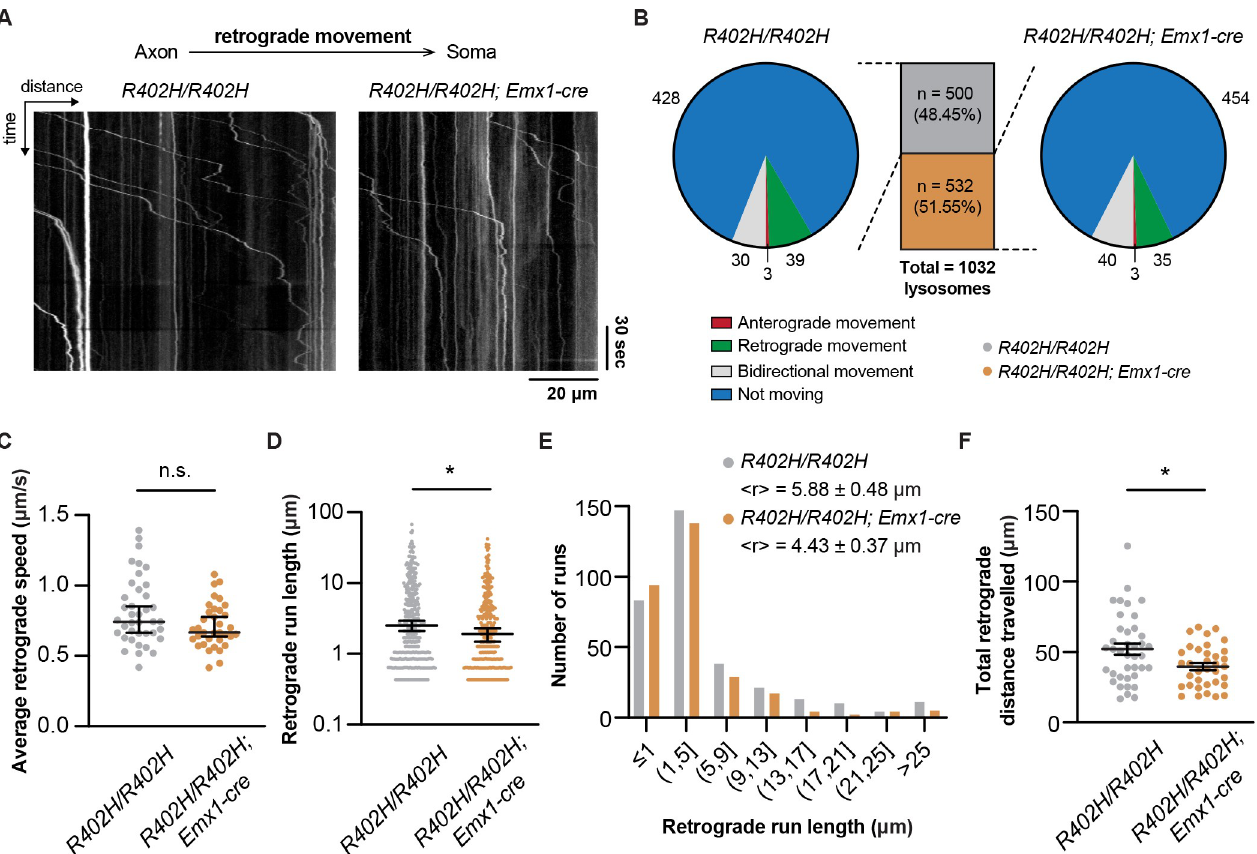
Fig 7. The R402H mutation perturbs dynein-mediated lysosomal transport. (A) Representative kymographs generated from lysosomes tracked in E18.5 primary cortical neurons in R402H/R402H controls and R402H/R402H; Emx1-cre mutants at DIV3. (B) Lysosomes (n = 1032) were classified according to their movement: anterograde, retrograde, bidirectional, immobile. There was no significant difference in the types of movement when comparing genotypes (Chi-square: 3.078, DF = 3, P = 0.3797). (C) We observed no difference in the average retrograde speed when comparing genotypes (n = 39 lysosomes for R402H/R402H controls and n = 35 lysosomes for R402H/R402H; Emx1-cre mutants P > 0.05), but a significant reduction in lysosomal retrograde run length (D) in R402H/R402H; Emx1-cre mutants (n = 343 runs for R402H/R402H controls and n = 309 runs for R402H/R402H; Emx1-cre mutants P < 0.05, with median retrograde run length of 2.52 μ m for R402H/R402H and 1.91 μ m for R402H/R402H; Emx1-cre animals). (E) Distribution of retrograde run lengths for R402H/R402H controls (in grey) and R402H/R402H; Emx1-cre mutants (in orange). (F) Total distance travelled in the retrograde direction is significantly reduced in R402H/R402H; Emx1-cre mutants. (n = 39 lysosomes for R402H/R402H controls and n = 35 lysosomes for R402H/R402H; Emx1-cre mutants P < 0.05). � P < 0.05. Error bars in C and D show the median ± 95% CI, and in F the mean ±